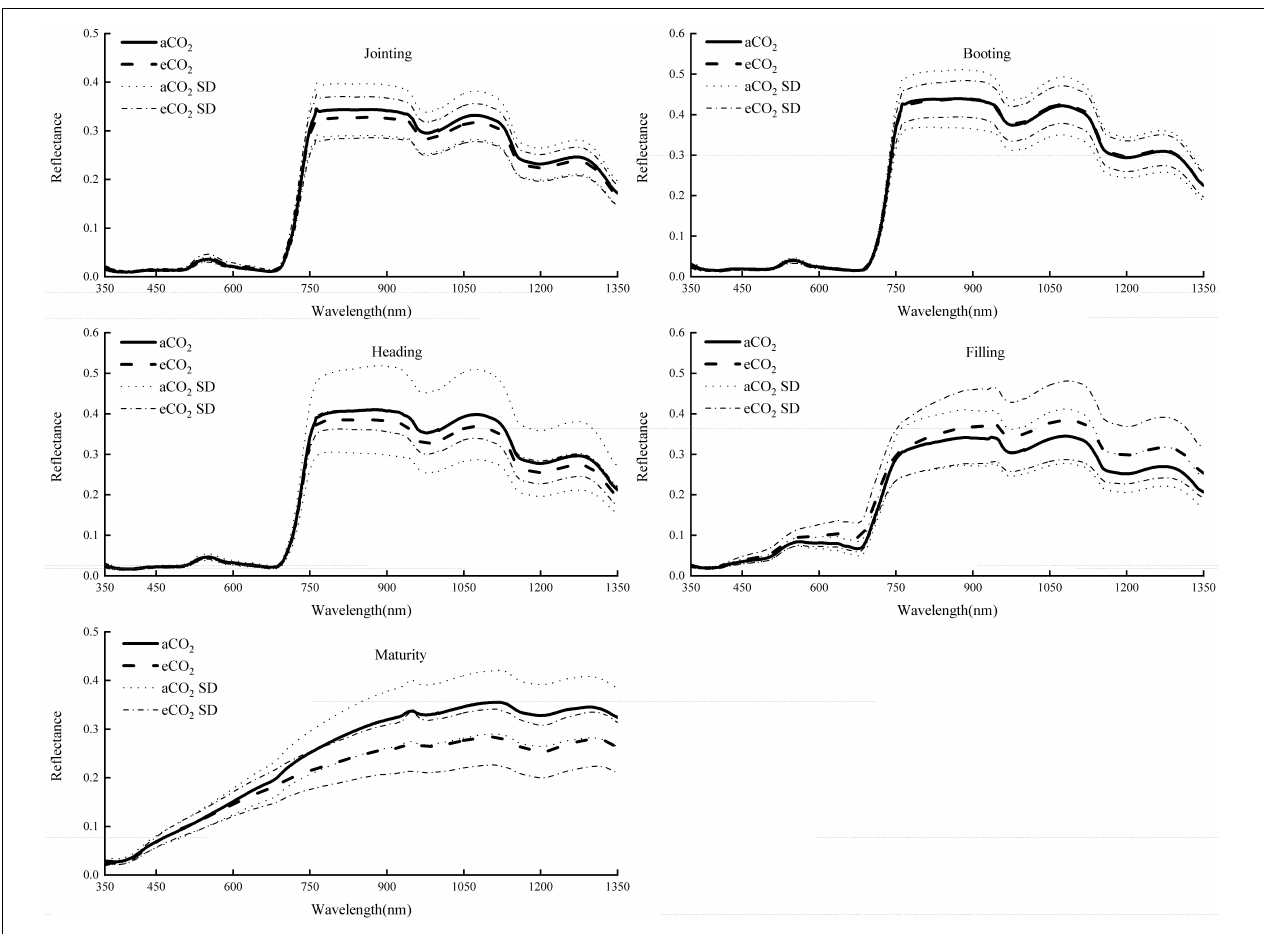
FIGURE 1 | Spectral reflectance of winter wheat canopy at different growing stages under aCO 2 and eCO 2 .